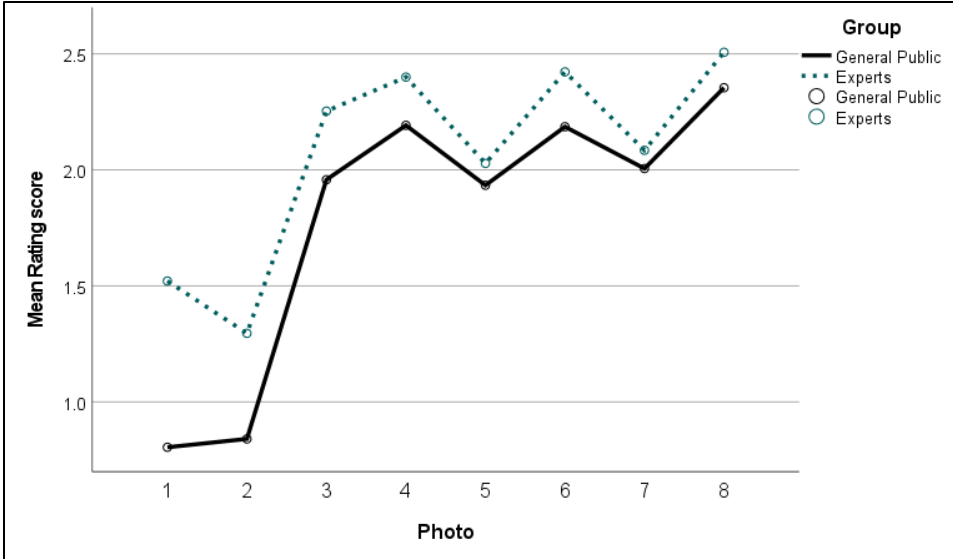
Figure 3. Mean rating scores of each context on the creation of sound.